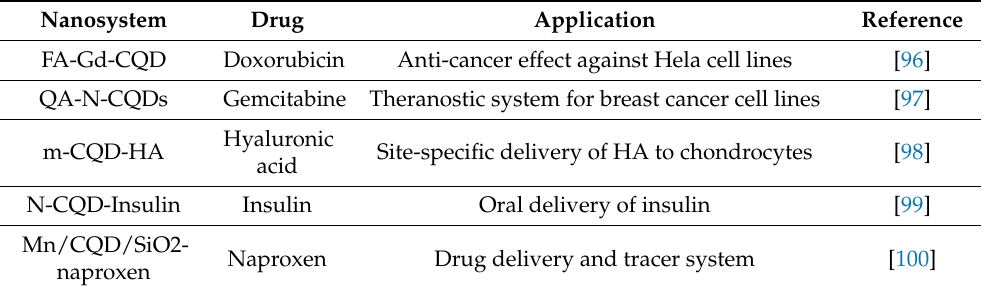
Table 5. Recent developments in CQD-based drug delivery